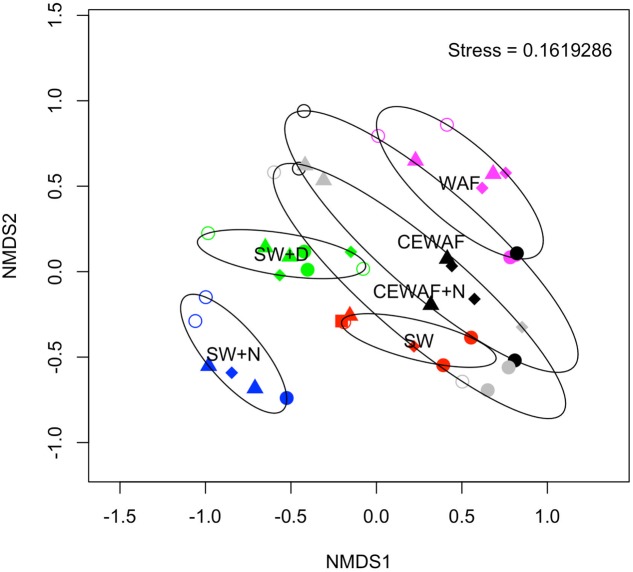
Non-metric multidimensional scaling (NMDS) plot showing the similarity of each sample. The stress achieved is indicated in the top right of the plot. Symbol colors signify the original treatment: SW (red); SW+N (blue); SW+D (green); WAF (purple); CEWAF (black); CEWAF+N (gray). Each time point is represented by a different symbol: T0 (square); T1 (open circle); T2 (triangle); T4 (diamond); T6 (closed circle). Ellipses shown surrounding symbols represent grouping the treatment types with 95% confidence interval.